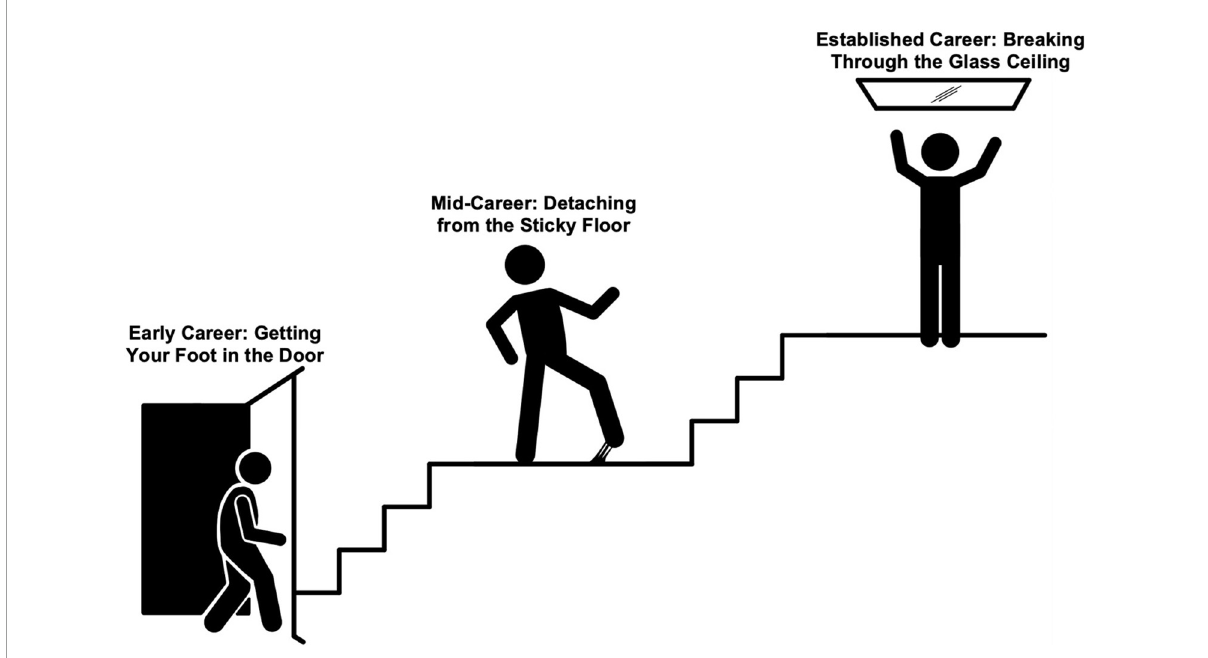
FIGURE1 Stages of challenges facing women entering heart failure and CT surgery.